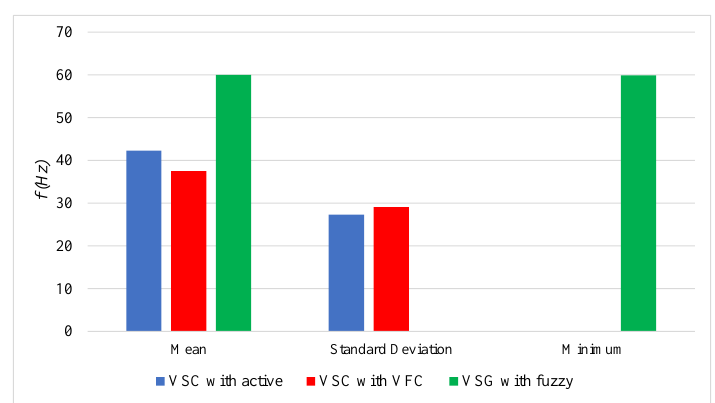
Figure 15. Microgrid frequency for different scenarios.